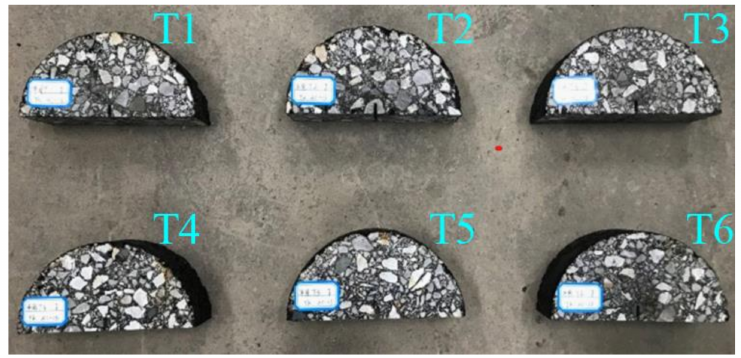
Figure 3. Formed specimens